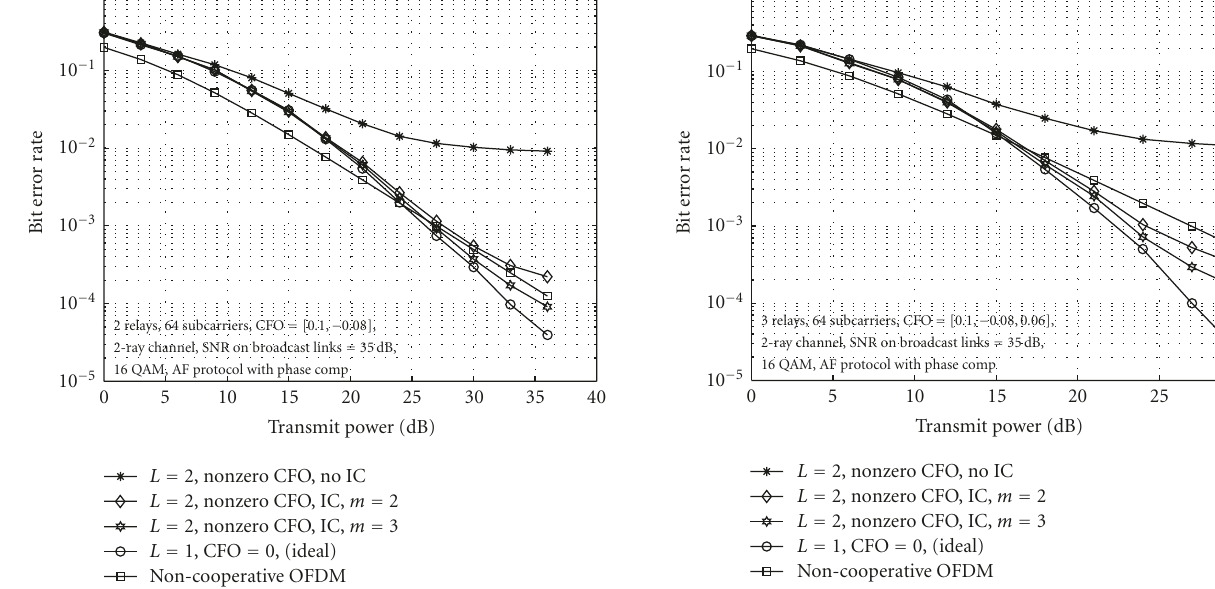
Figure 4: BER performance as a function of SNR for CO-SFBC- OFDM on frequency-selective fading ( L = 2). M = 64, 2 relays ( N = 2, G 2 code), CFO = [0.1, − 0.08], 16-QAM, SNR on broadcast links = 35 dB. AF protocol and phase compensation at the relays.